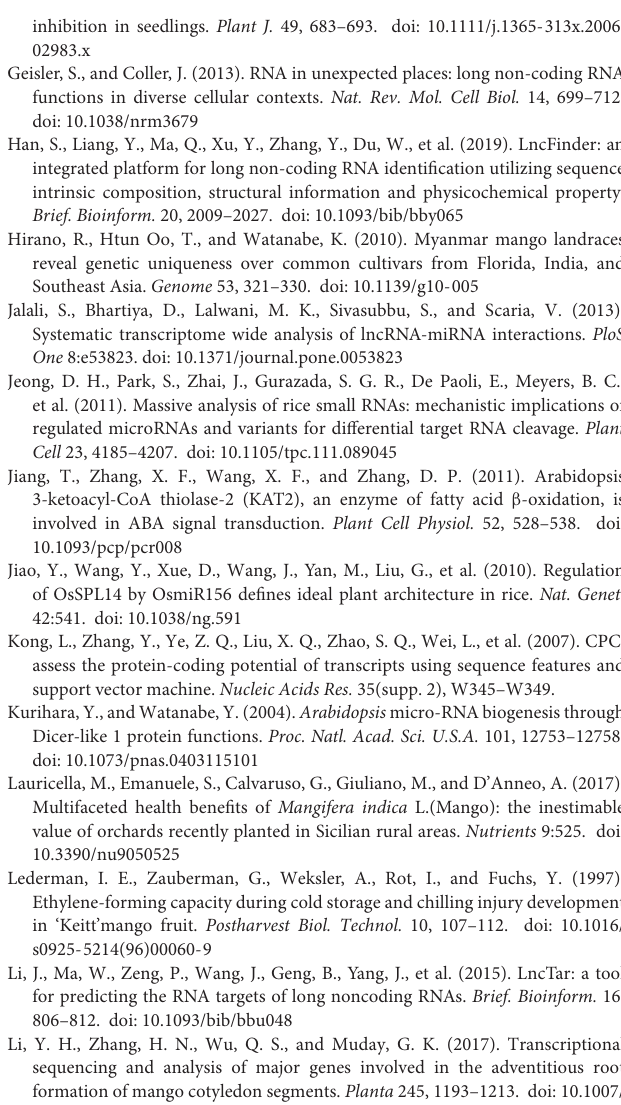
Supplementary Table 1 | miRNAs data. Supplementary Table 2 | miRNAs targets data. Supplementary Table 3 | Heat responsive lncRNAs data. Supplementary Table 4 | Cold responsive lncRNAs data. Supplementary Table 5 | KEGG pathways of the target of heat responsive lncRNAs. Supplementary Table 6 | KEGG pathways of the target of cold responsive lncRNAs. Supplementary Table 7 | Heat responsive lncRNAs as target of miRNAs. Supplementary Table 8 | Cold responsive lncRNAs as target of miRNAs. Supplementary Table 9 | Cold responsive lncRNAs as target mimic of miRNAs. Supplementary Data Sheet 1 | Heat responsive lncRNAs sequences. Supplementary Data Sheet 2 | Cold responsive lncRNAs